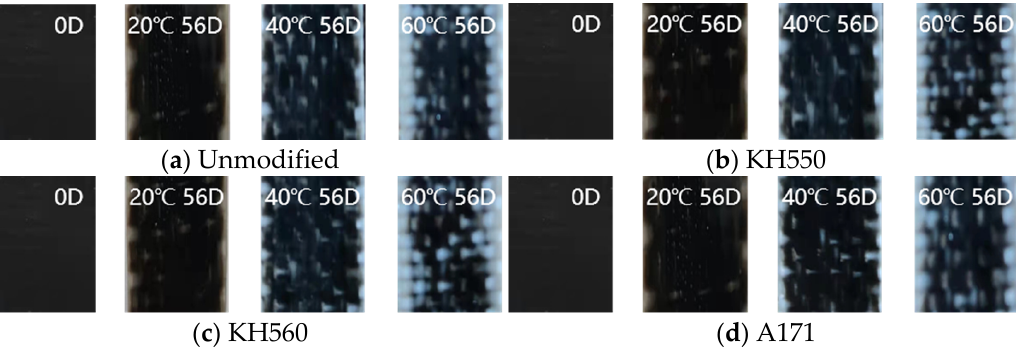
Figure 10. Appearance changes in a 10% H 2 SO 4 acid environment.